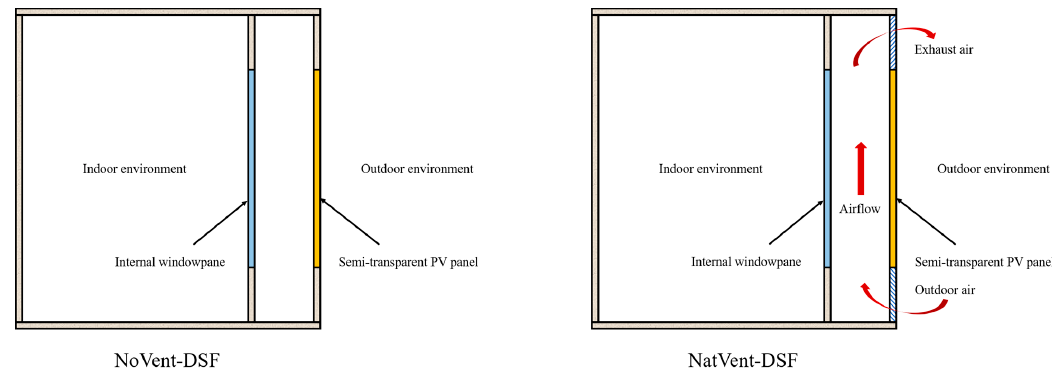
Figure 2. Front view of the office module with BIPV-DSF.